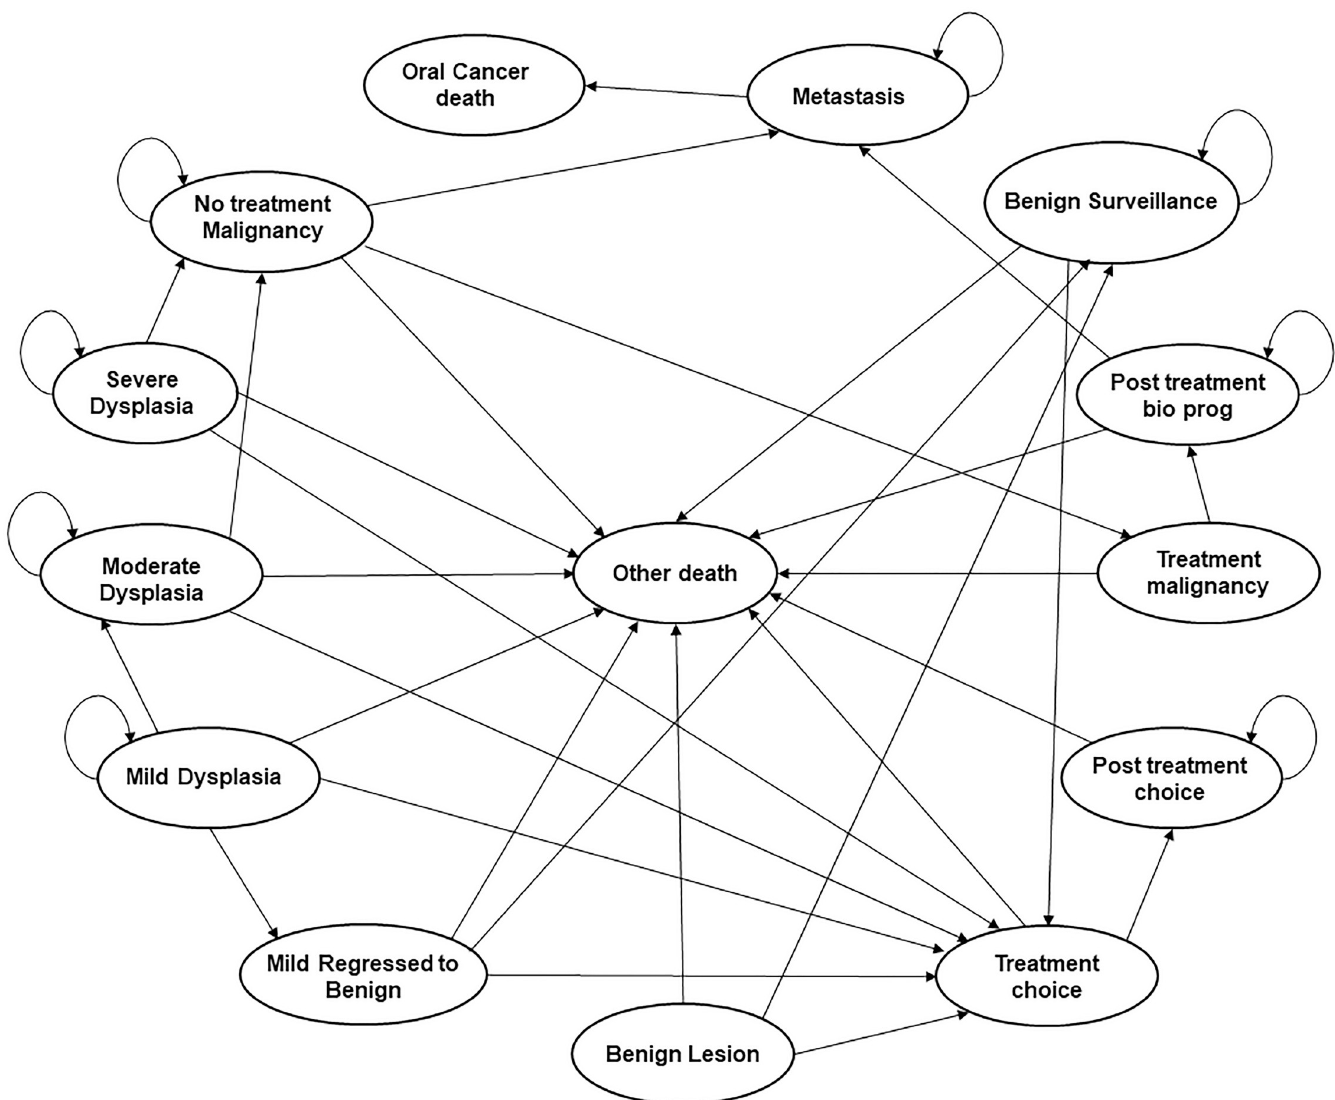
Fig 1. State transition diagram for the strategies using the POCOCT. Mild dysplasia may be surgically removed in pathways designated for treatment, or if monitored, regress to benign lesions or progress to moderate dysplasia. Similarly, moderate and severe dysplasia are treated if in a designated treatment pathway, or if monitored, can progress to malignancy. Malignant lesions are treated if detected, or if left untreated may metastasize. Represented causes of death include metastatic disease or other all-cause mortality. https://doi.org/10.1371/journal.pone.0244446.g001 test-and treat pathways the decision to treat is based on the various histopathological diagnoses rendered by specialist biopsy. In the non-invasive pathways, the decision to refer and treat is based on a positive POCOCT test outcome and given that the threshold or cut-off for a posi- tive POCOCT test is an accurate surrogate for histopathology, it is possible to set these test thresholds across multiple diagnostic splits. The sensitivity and specificity of POCOCT for each diagnostic split was defined in a prior diagnostic accuracy trial [16, 18]. The splits include benign vs any dysplasia/carcinoma (benign|mild split) where, as an example, OPMDs that have no actual dysplasia and are benign would receive a negative POCOCT outcome and OPMDs harboring mild dysplasia or worse histopathology would receive a positive POCOCT